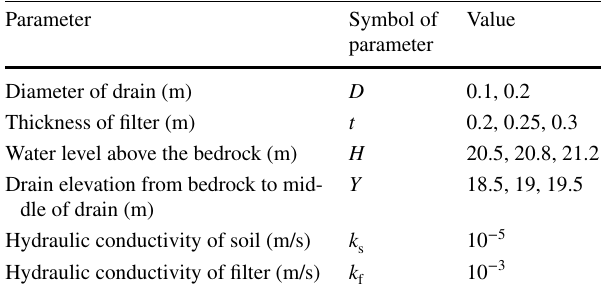
Table 1 Physical and hydraulic properties of the simulation